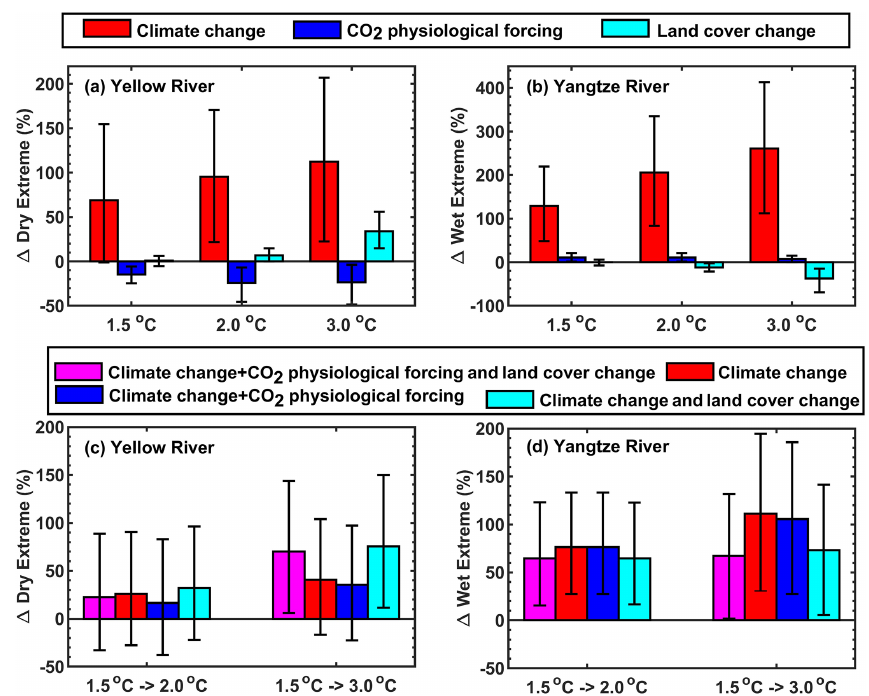
Figure 7. (a–b) Influences of climate change, CO 2 physiological forcing and land cover change on relative changes in frequency of the dry and wet extremes in July–September at different global warming levels for the headwater regions of Yellow River and Yangtze River. (c–d) Changes of dry and wet extremes under additional warming of 0.5 and 1.5 ◦ C with the consideration of different factors. All the changes are relative to the reference period (1985–2014). Ensemble means are shown by colored bars, while the 5%–95% uncertainty ranges estimated using bootstrapping 10000 times are represented by error